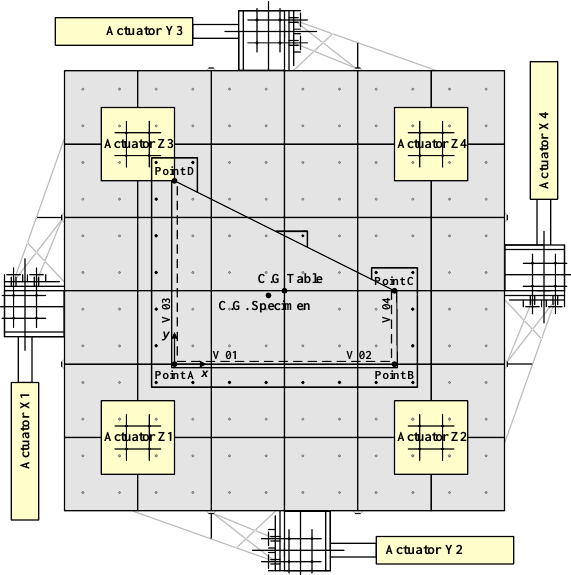
Figure 4. Plan view of the SMART 2013 structure positioned on the shaking table [23]; four hydraulic actuators (X1, X4, Y2, Y3) are placed in a horizontal direction, and the other four (Z1, Z2, Z3, Z4) are laid in a vertical direction.